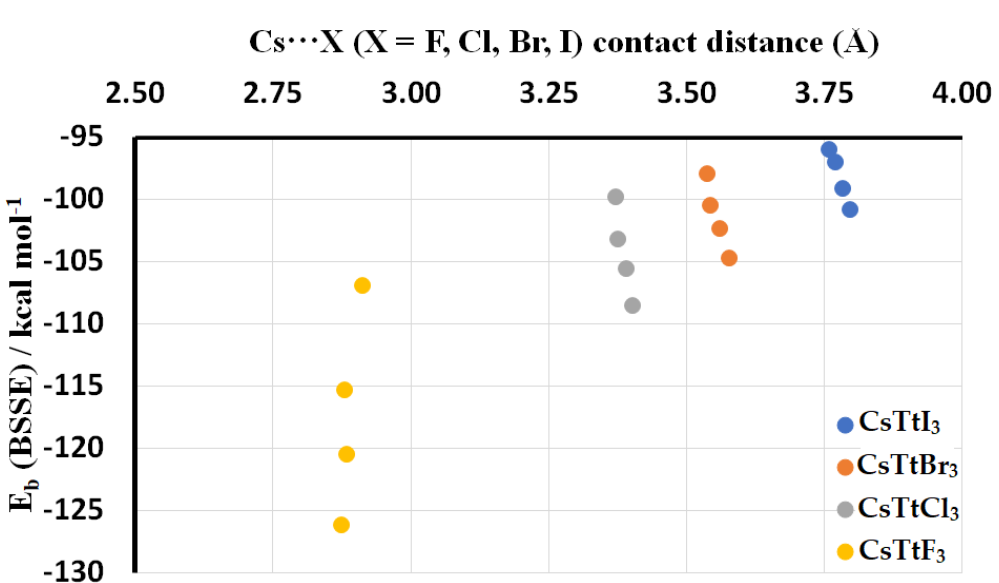
Figure 17. The relationship between interaction energy and the interionic distance in [Cs + •TtX 3 − ] (Tt = Sn, Ge, Sn, Pb; X = F, Cl, Br, I) ion